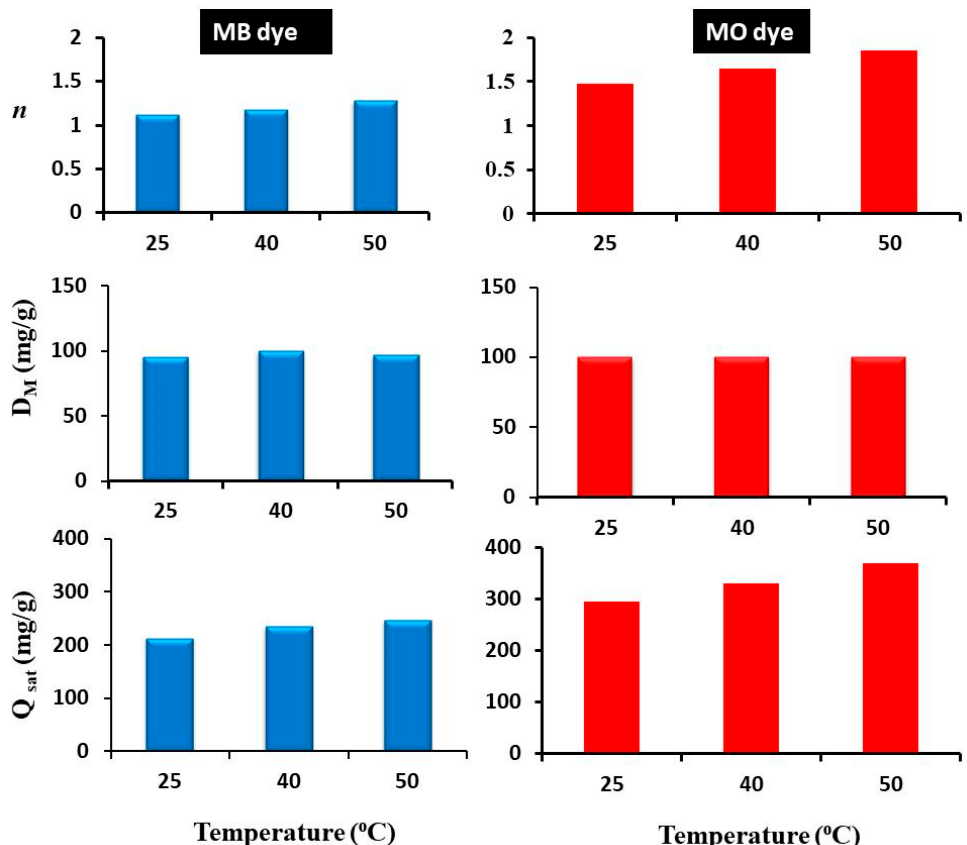
Figure 6. Physicochemical parameters n, D M , and Q sat as a function of temperature for MB and MO adsorption on the Rt/BC adsorbent. Table 1. Steric parameters of the double layer model for the adsorption of MB and MO on the Rt/BC composite.